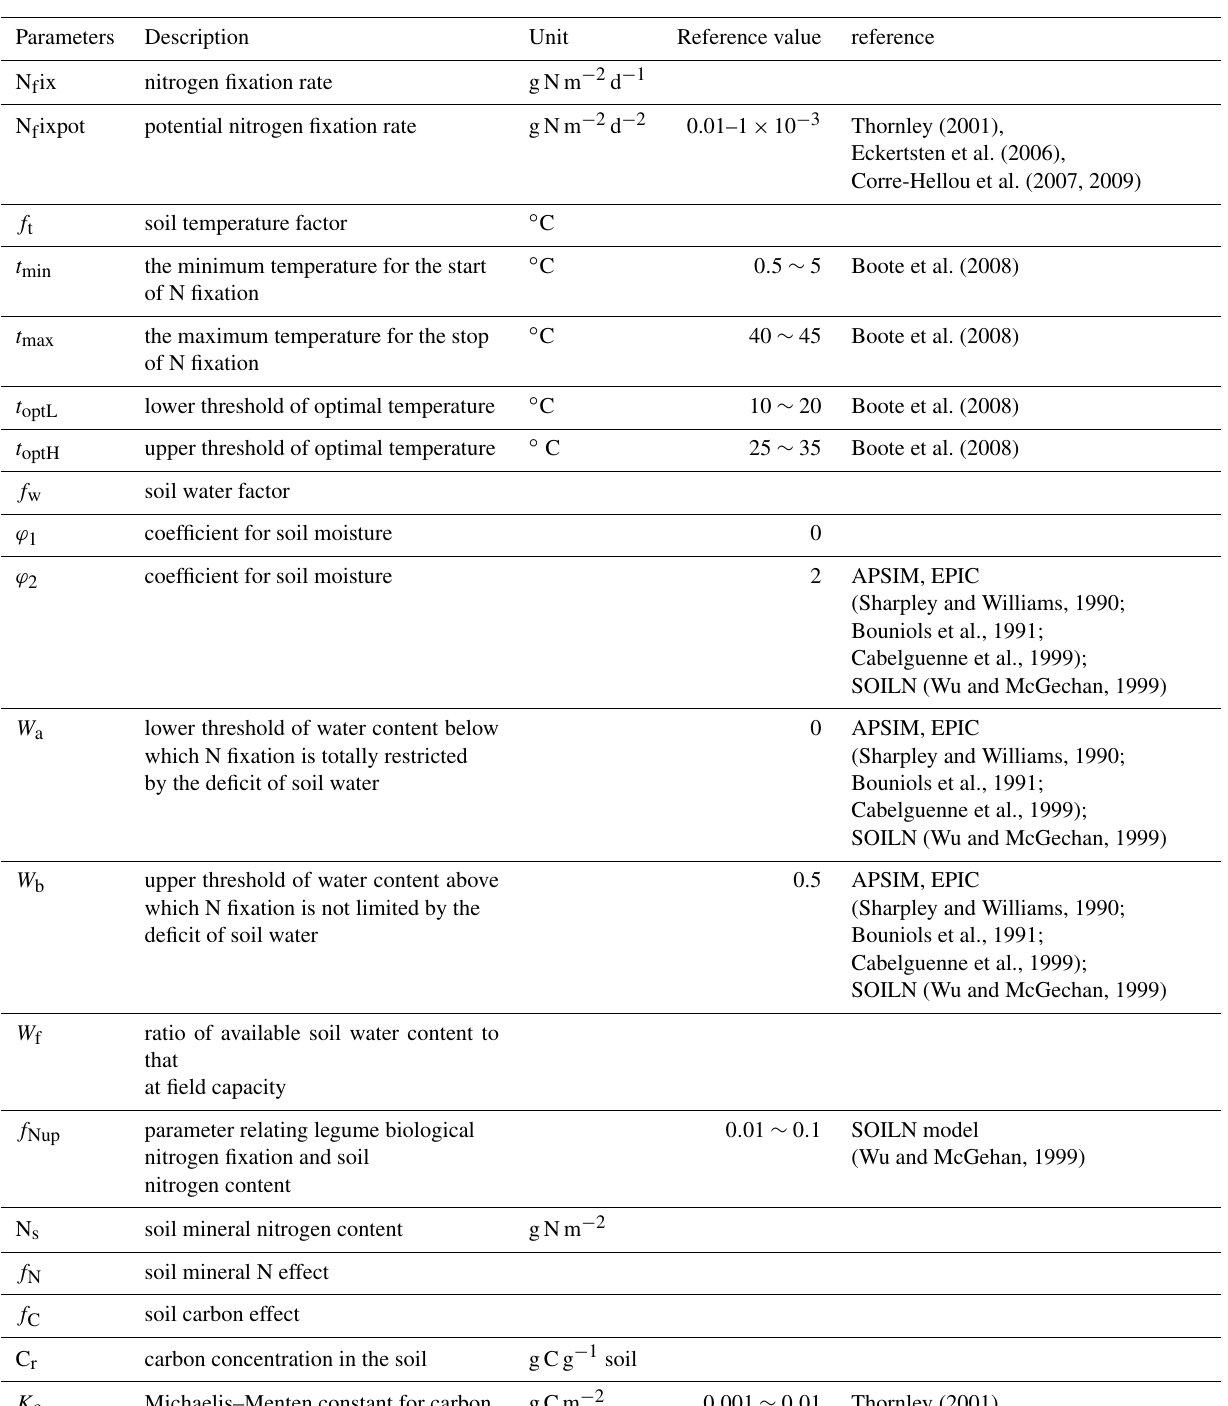
Table 1. Description of parameters used in the